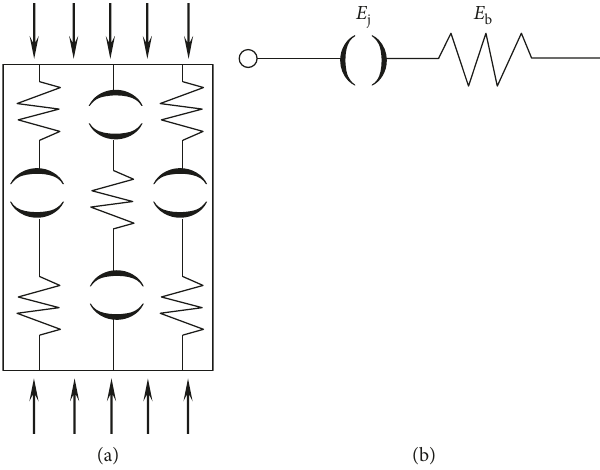
Figure 12: The deformation mechanism of the rock-loose coal composite system with bolt: (a) physical model of RCB(1 ∼ 2); (b) deformation